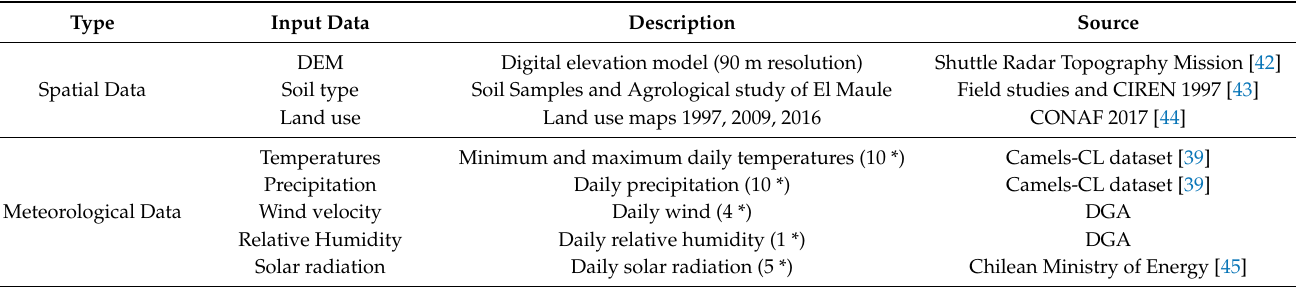
Table 1. Input parameters used for SWAT+